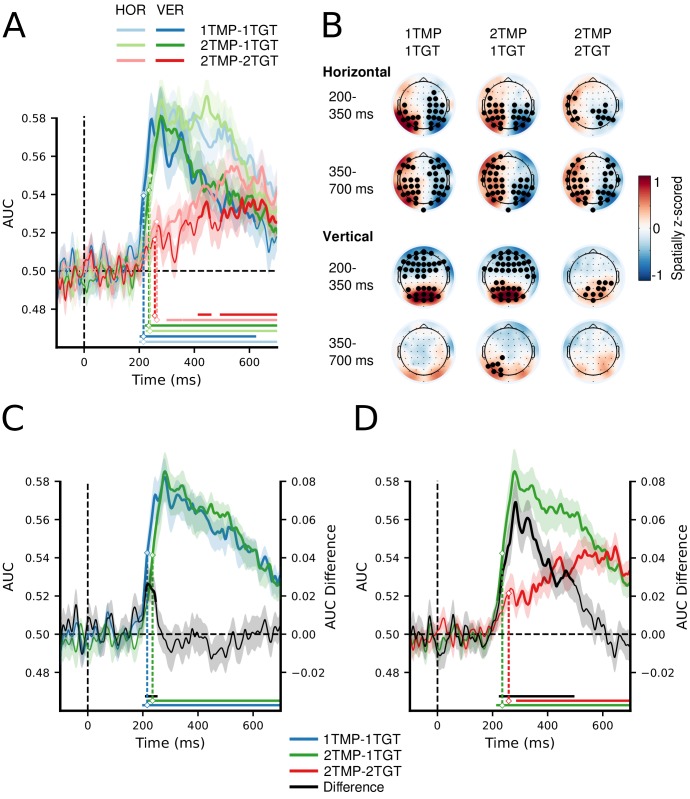
MVPA decoding performance for target position.(A) Decoding performance expressed as Area Under the Curve (AUC) for target position on the horizontal (left vs. right) and on the vertical meridian (top vs. bottom) separately, as a function of number of templates and number of target features. See also Figure 2—source data 1 (B) Topographical activation maps for horizontal and vertical position decoding averaged over the typical N2pc time window (200–350 ms) and the typical SPCN/CDA time window (350–700 ms). (C) Decoding performance collapsed across the horizontal and vertical dimensions, comparing the 1TMP–1TGT and 2TMP–1TGT conditions, with the difference score thus showing the effect of the number of templates. See also Figure 2—source data 2. (D) The same, now comparing the 2TMP–1TGT and 2TMP–2TGT conditions, thus showing the effect of multiple different target features in the display. See also Figure 2—source data 2. The shaded area represents 1 SEM above and below the mean for every time point. Thick lines as well as horizontal bars indicate significant clusters (at α = 0.05) as produced by cluster-based permutation testing (5000 permutations). For visualization purposes only, the classification scores over time were fitted with a cubic spline (λ = 15, comparable to a 30 Hz low-pass filter) to achieve temporal smoothing. Note the statistical analyses and estimation of the onset latencies were done on unsmoothed data. The marked time points indicate the latency of 50% maximum amplitude as estimated using a jackknife approach, as a measure of the onset of selection (Miller et al., 1998; Luck, 2014; Liesefeld, 2018). The zero points on the x-axis of panels A,C and D represent search display onsets.10.7554/eLife.49130.009Figure 2—source data 1.Time series data of classification AUC scores, separately for each condition and horizontal and vertical targets, as shown in Figure 2A.10.7554/eLife.49130.010Figure 2—source data 2.Time series data of classification AUC scores, separately for each condition (incl. separately for 21TGT switch and repeat trials), but collapsed across target position, as shown in Figure 2C, D and Figure 2—figure supplement 2.